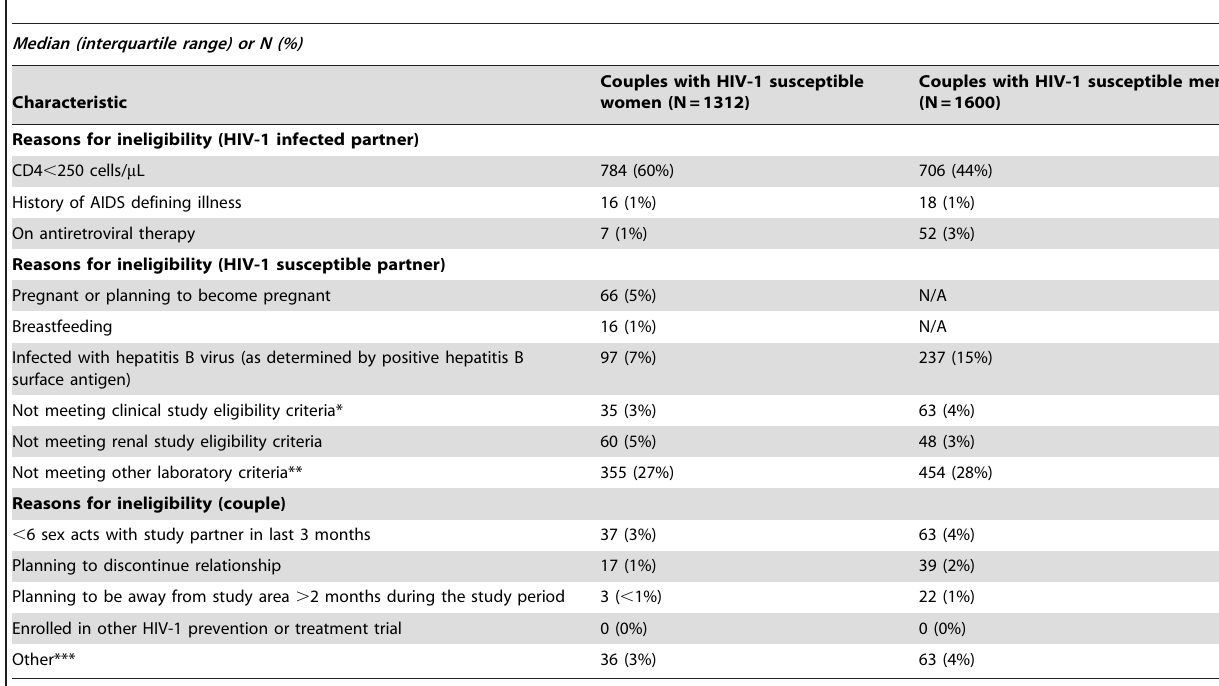
Table 4. Reasons for Screening Out of Ineligible HIV-1 Serodiscordant Couples (N= 2912).